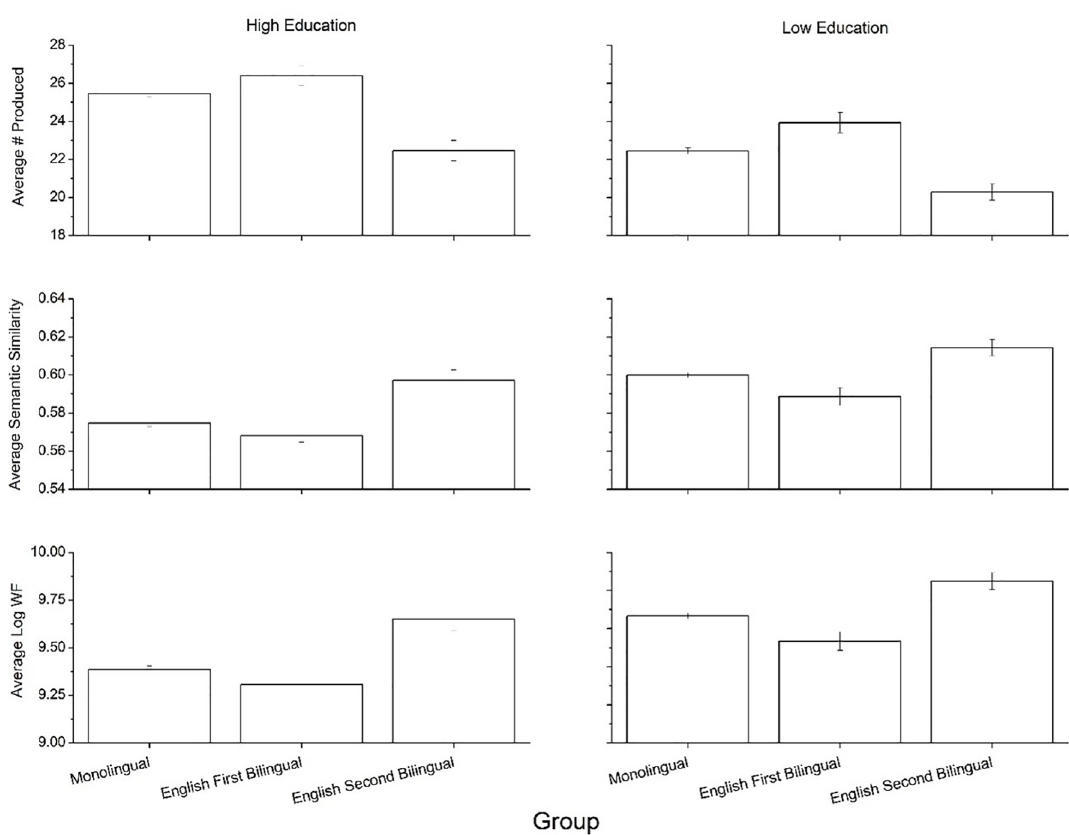
Fig 5. Means for the three psycholinguistic variables by language and education level. Error bars represent 95% confidence intervals.